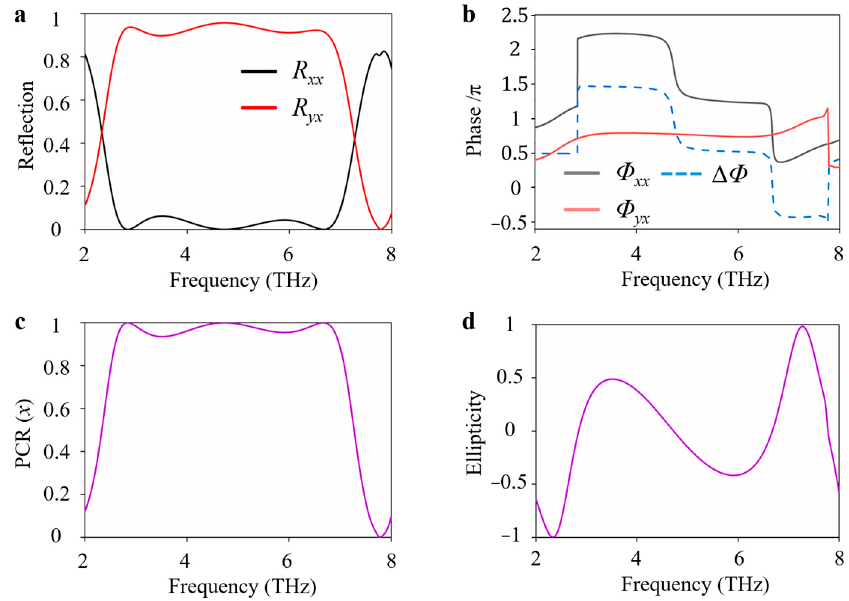
Figure 3. ( a ) The reflection spectra of forward illuminated x -polarized light when VO 2 is in the metallic state. ( b ) The spectra of the phase and the calculated phase difference of the two reflection coefficients. ( c ) The PCR spectra for forward incident x -polarized light, and ( d ) the calculated ellipticity spectra.